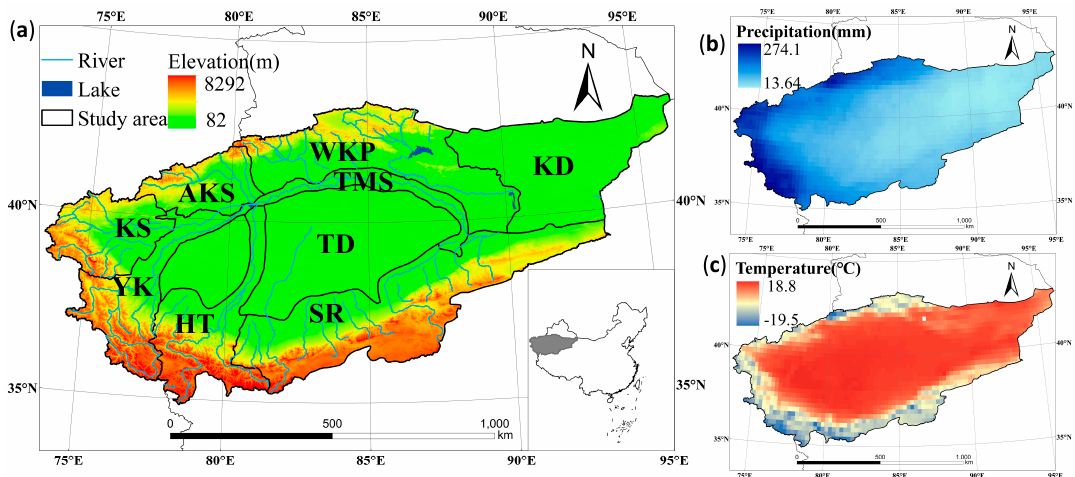
Figure 1. The DEM ( a ); precipitation ( b ); and temperature ( c ) in 2019 of the TRB. HT, Hotan River Basin; YK, the Yarkant River Basin; KS, Kashgar River Basin; AKS, Aksu River Basin; WKP, Weikan-Kaidu-Peacock River Basin; SR, Rivers in Southern Xinjiang; TMS, the Tarim Main Stream; TD, Taklamakan Desert; KD, Kumtag